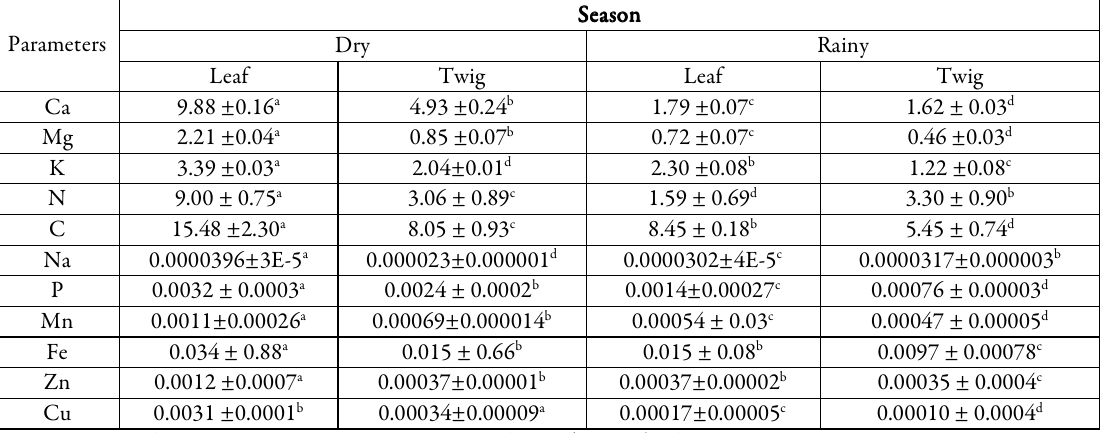
Figure 3c. Monthly nutrient deposition via litter fall in the bamboo stands in a Regenerating forest, Ile-Ife *Vertical bars of the same alphabet in a month are not significantly (P > 0.05) different using Duncan Multiple Range Test (DMRT).... Table 1. Nutrient element deposition (kg ha -1 ) in the litter standing crop of the bamboo stands at the peak of seasons in a regenerating rainforest,